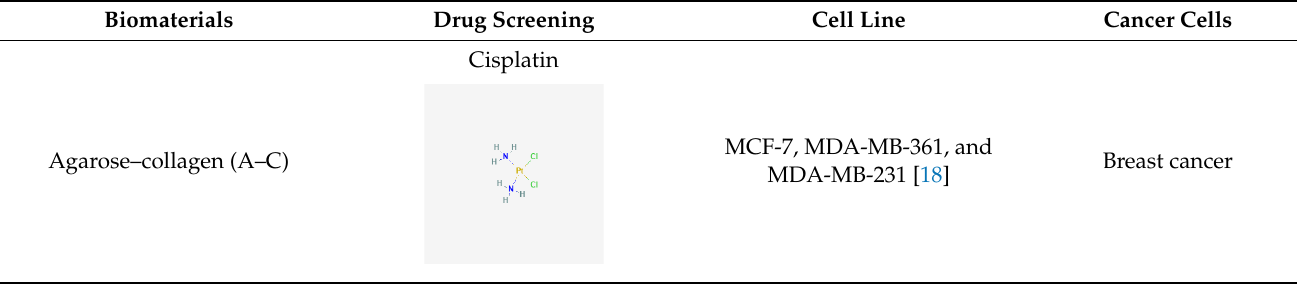
Table 1. Three-dimensional cell culture of cancer cells combined with biomaterials.